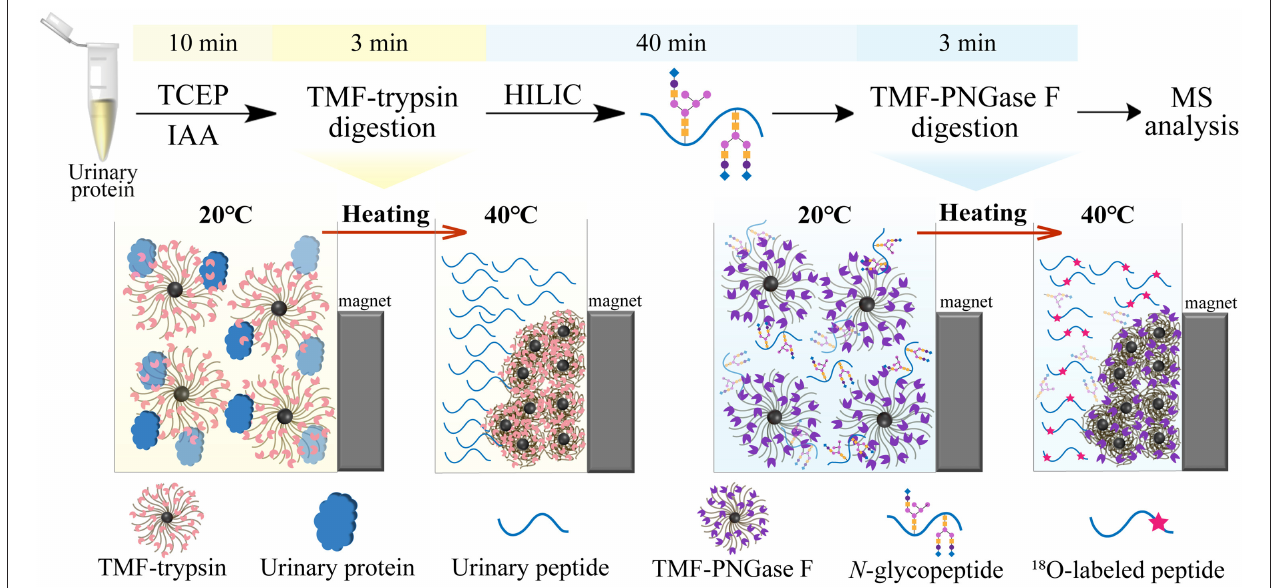
FIGURE 1 | Workflow of ultrafast N- glycoprotein analysis by TMF–trypsin digestion and TMF–PNGase F